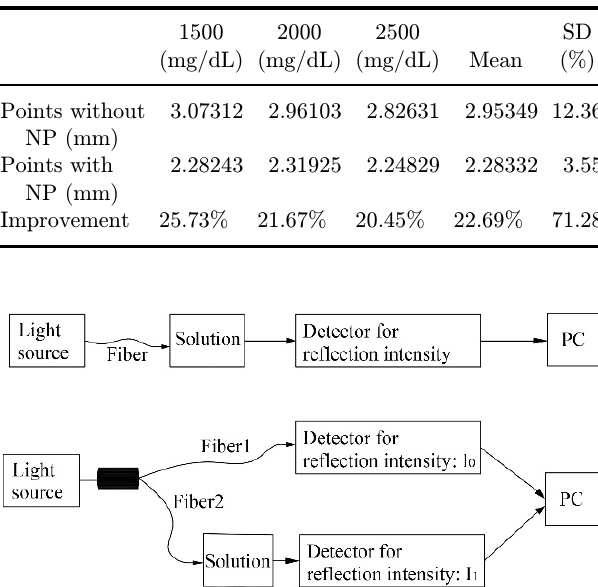
Table 13. Errors of light source drift of experimental measurements.